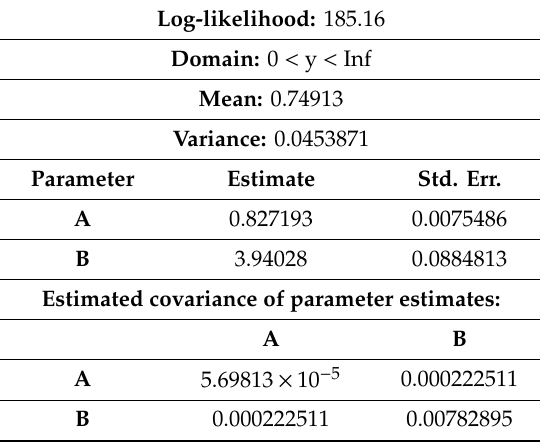
Table 2. Weibull distribution